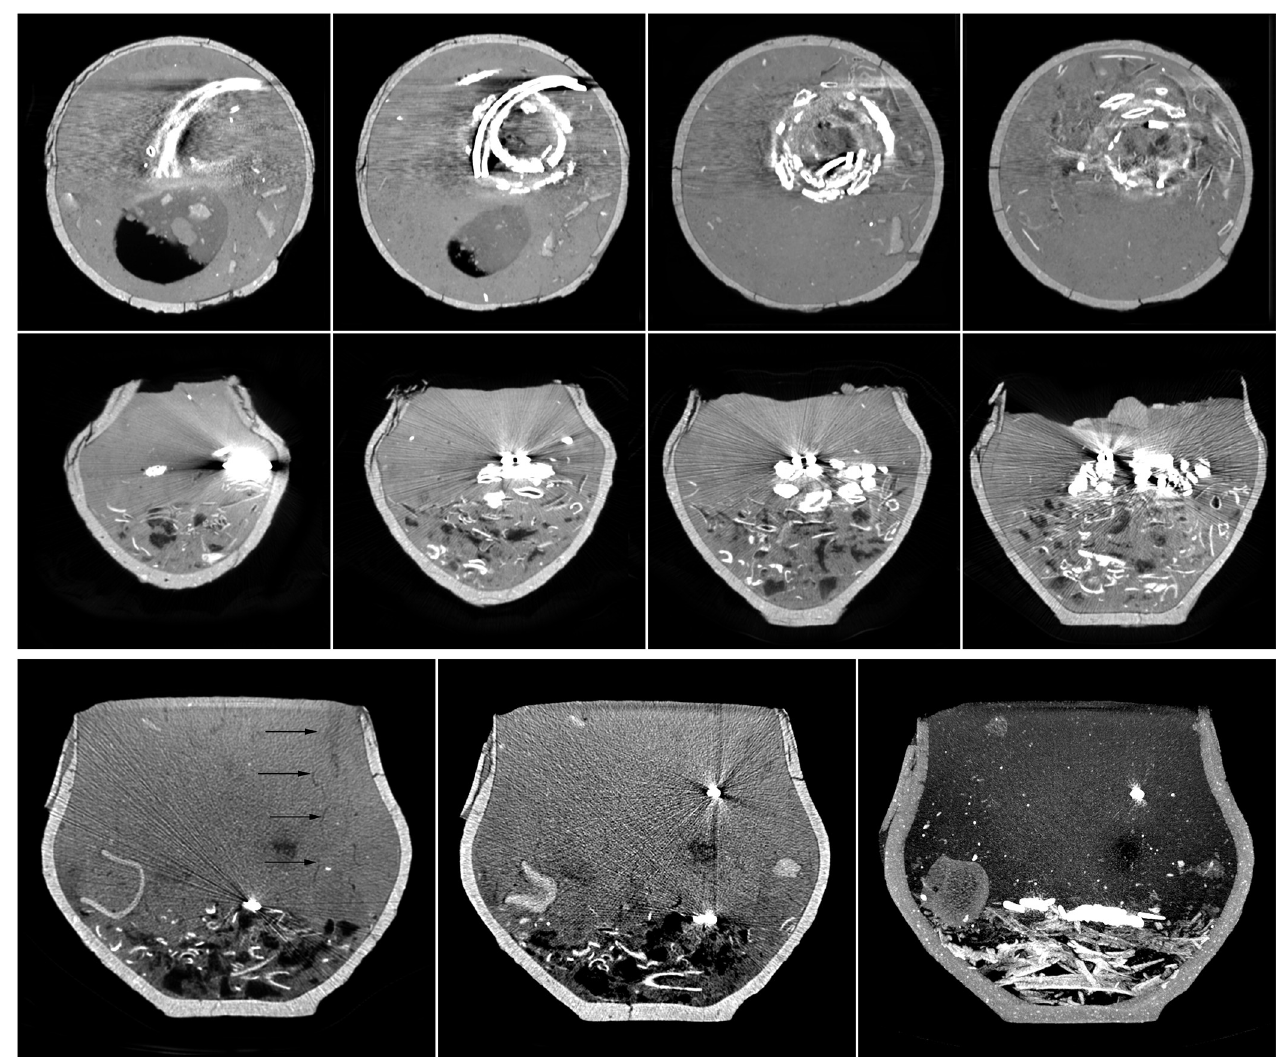
Fig 11. Examples of metal-related artifacts in CT slices of the urns from graves 528 and 548. The upper two rows show the fill of the urn from grave 528, in which the presence of iron ornaments made it impossible to visualize traces of soil fauna activity. Artefacts are visible in the form of bright and dark streaks interfering with the reading of the imaging itself. The lower row shows artefacts of a similar type that were recorded in the CT imaging of the fill of urn 548. In this case, it was possible to identify a disappearing rodent burrow (black arrows), in which there is now a piece of metal that has been displaced significantly above its original